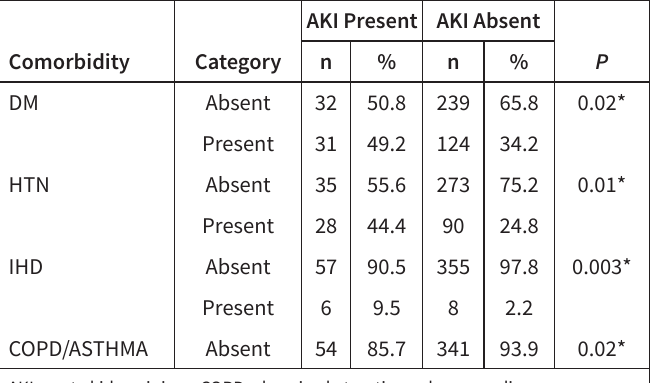
Table 7. Comparison of Presence of Proteinuria with Comorbid Conditions of Patients Using Chi-Square Test